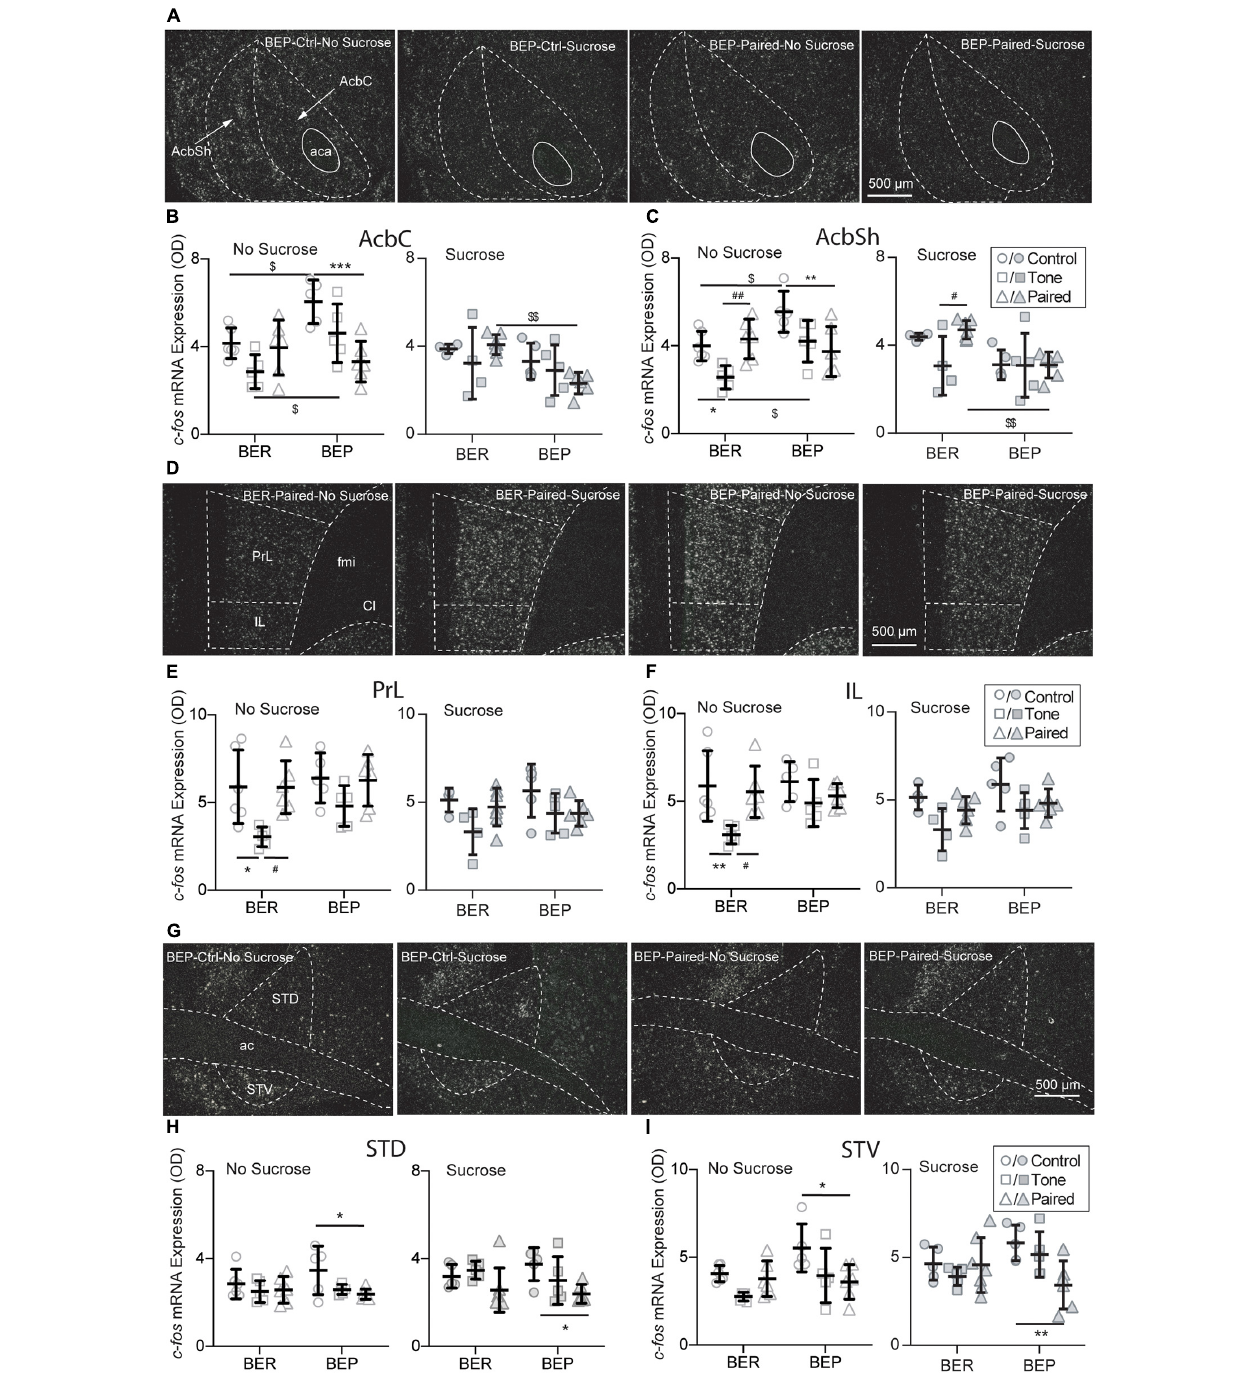
FIGURE 6 | Effects of fear conditioning on the c-fos mRNA expression in the Acb, mPFC, and BNST. Representative images of the c-fos mRNA in situ hybridization signals with the core (AcbC) and shell (AcbSh) part of the nucleus accumbens (Acb), the prelimbic part (PrL), and infralimbic (IL) part of the medial prefrontal cortex (mPFC), and the dorsal part (STD) and ventral (STV) part of the bed nucleus of stria terminalis (BNST) marked with broken contours (A,D,G) . Relative c-fos mRNA expression of No Sucrose and Sucrose groups and Paired groups in the Acb (B,C) , mPFC (E,F) , and BNST (H,I) of BERs and BEPs. ac, anterior commissure; aca, anterior part of the anterior commissure; LV, lateral ventricle; ic, internal capsule; fmi, forceps minor of the corpus callosum; Cl, claustrum. *Significantly different ( p < 0.05) from the Control group with the same phenotype. ** p < 0.01, *** p < 0.001. # Significantly different ( p < 0.05) from the Tone group with the same phenotype. ## p < 0.01. $ Significantly different ( p < 0.05) from the BER group with the same treatment. $$ p < 0.01.